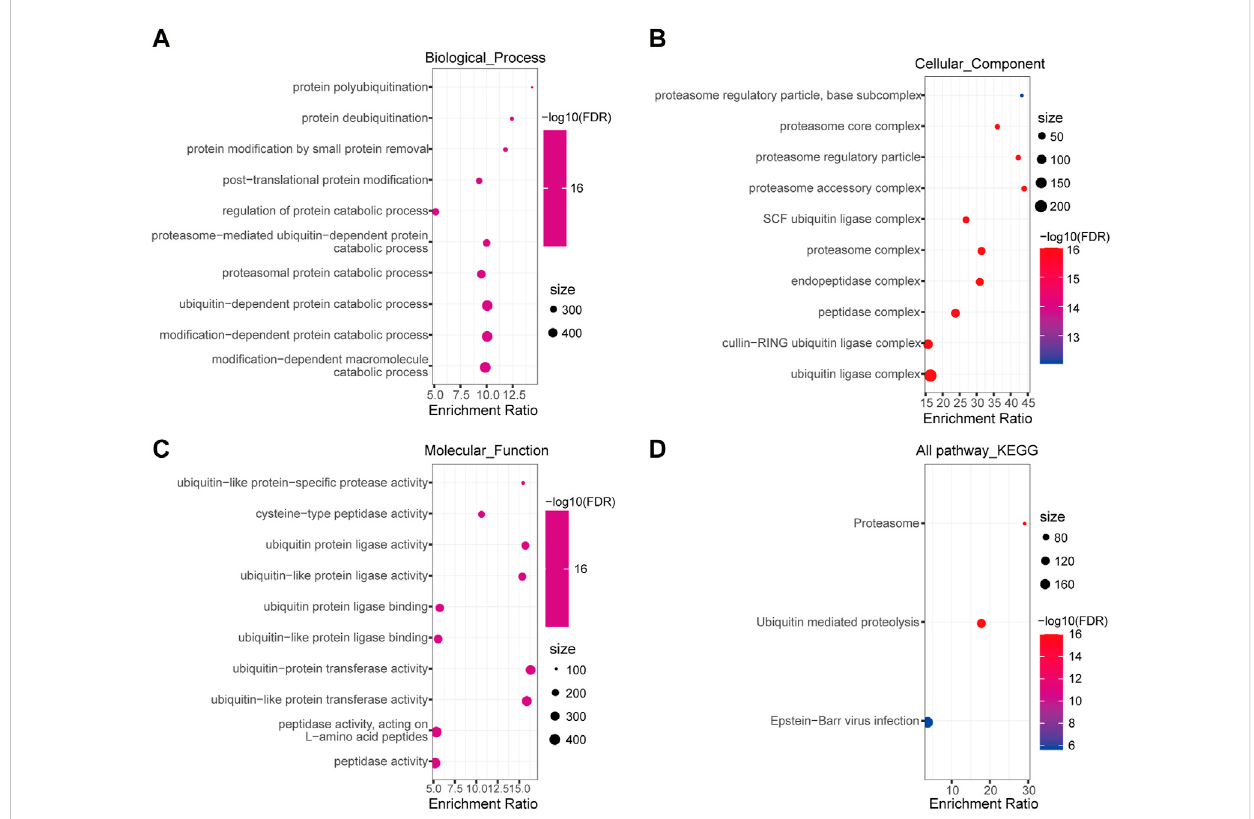
FIGURE 2 Enrichment analyses of DEUPS in HCC. (A – C) Top 10 terms in BP, CC, and MF categories. (D) KEGG Pathway analyses of